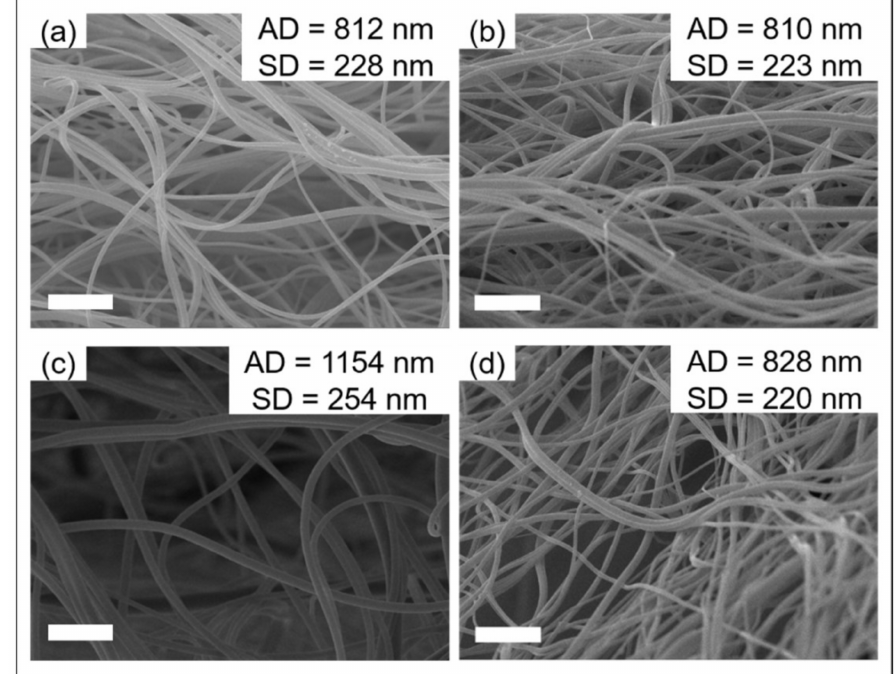
Figure 2. SEM images of nanofibers via co-axial centrifugal spinning. ( a ) Sample G: 7 w / v % PEO and 2:1 CCS/PEO; ( b ) Sample H: 6 w / v % PEO and 2:1 CCS/PEO; ( c ) Sample I: 7 w / v % PEO and 1:1 CCS/PEO; ( d ) Sample J: 6 w / v % PEO and 1:1 CCS/PEO. Scale bar: 10 µ